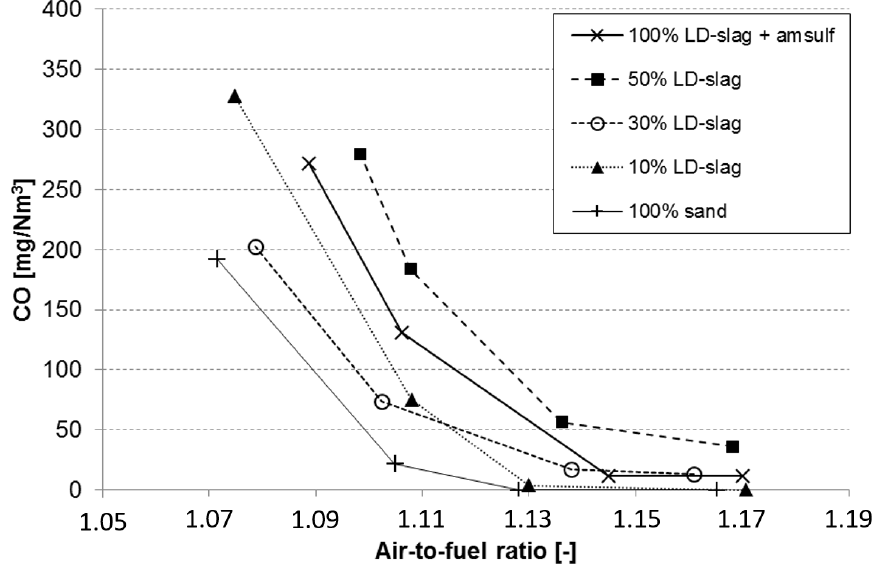
Figure 6. Measured concentrations of CO (mg/Nm 3 , at 6% O 2 ) at position kh2 in the convection path as a function of the air-to-fuel ratio.